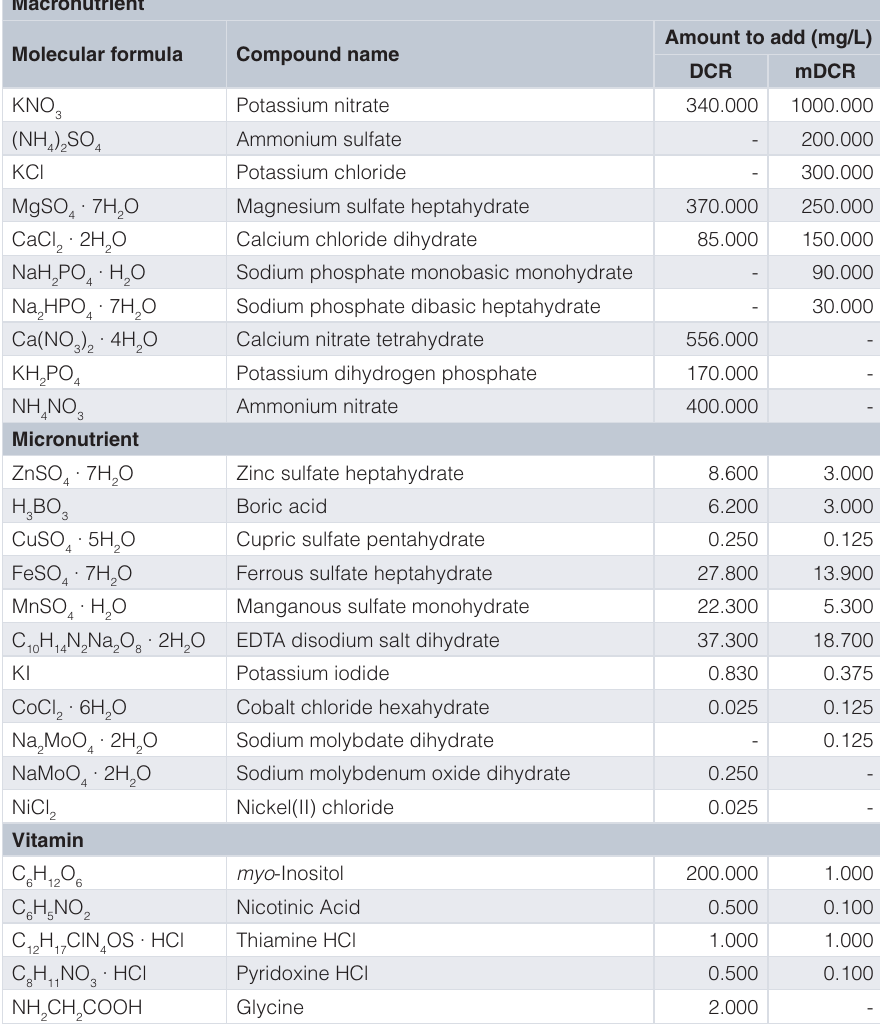
Table 1. Medium formulation comparison of DCR vs.